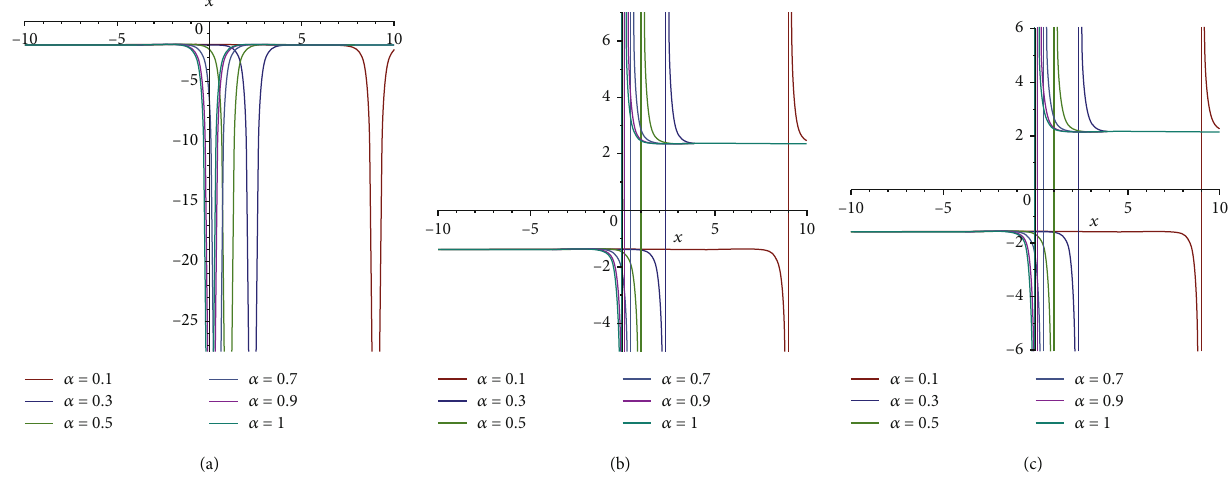
= ν = τ = c = 1and t = 1 fordiffernt values of α . − 1